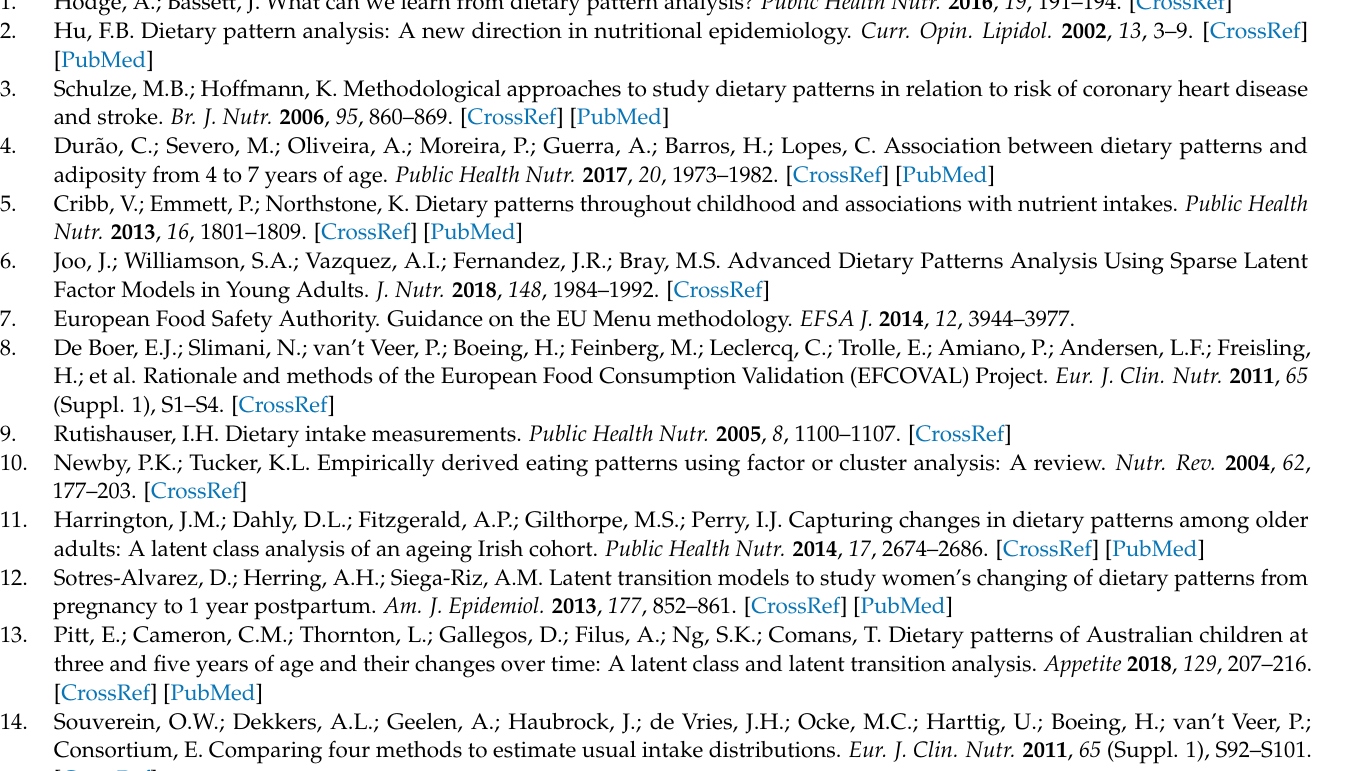
Supplementary Materials: The following are available online at https://www.mdpi.com/2072-664 Table S2: Probabilities of food group consumption conditional on a dietary pattern derived by the latent class model with concomitant variables (age and